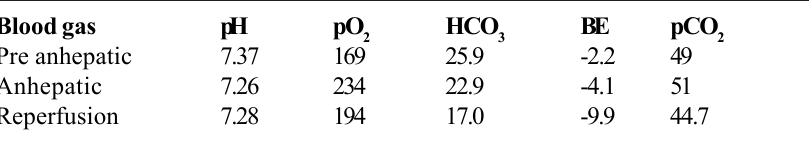
TABLE 4 - Blood gas analysis in the recipients